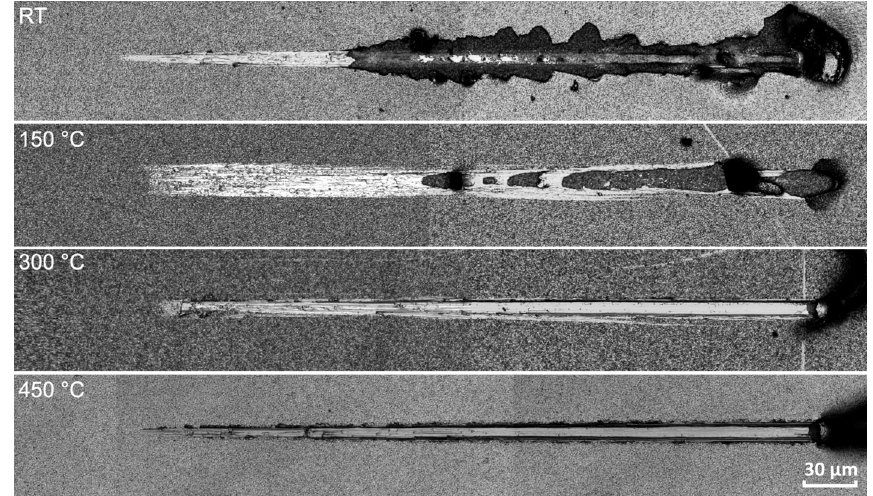
Figure 4. Typical scratch tracks for Ti films deposited at temperatures ranging from room temperature (RT) to 450 °C.